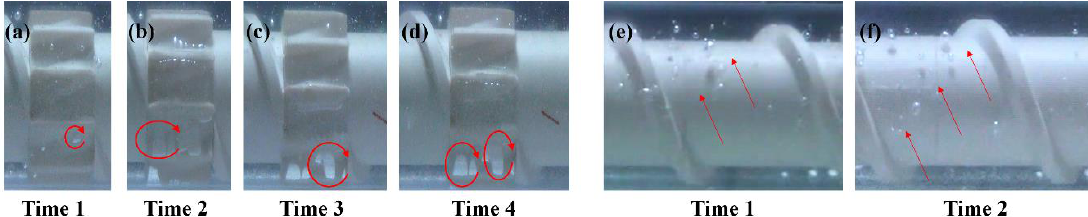
Figure 10. Flow patterns of bubbles in the TOEs and STDs channels at different time: ( a ) Time 1 in TOE channel; ( b ) Time 2 in TOE channel; ( c ) Time 3 in TOE channel; ( d ) Time 4 in TOE channel; ( e ) Time 1 in STD channel; ( f ) Time 2 in STD channel.